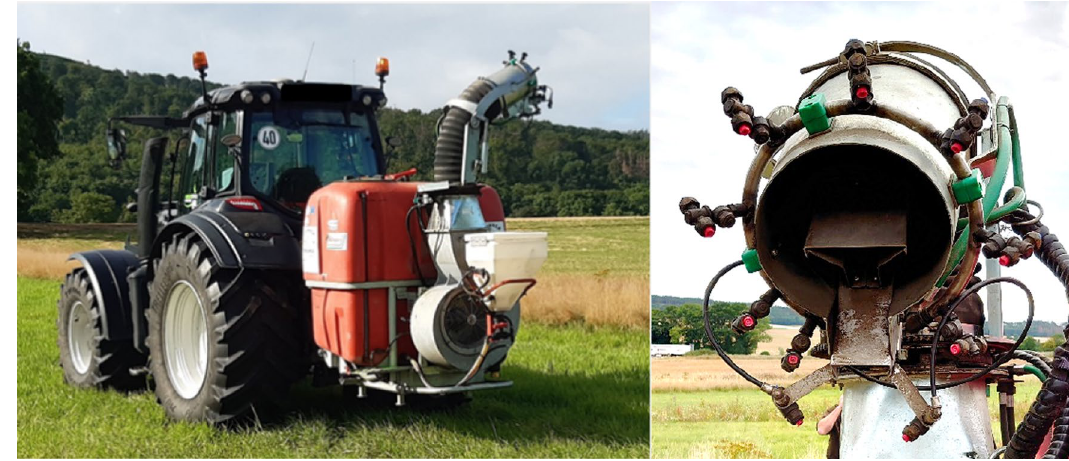
Fig. 1 Tractor‑mounted cannon sprayer Dragone AZ2 (left) with hydraulic atomiser (right)